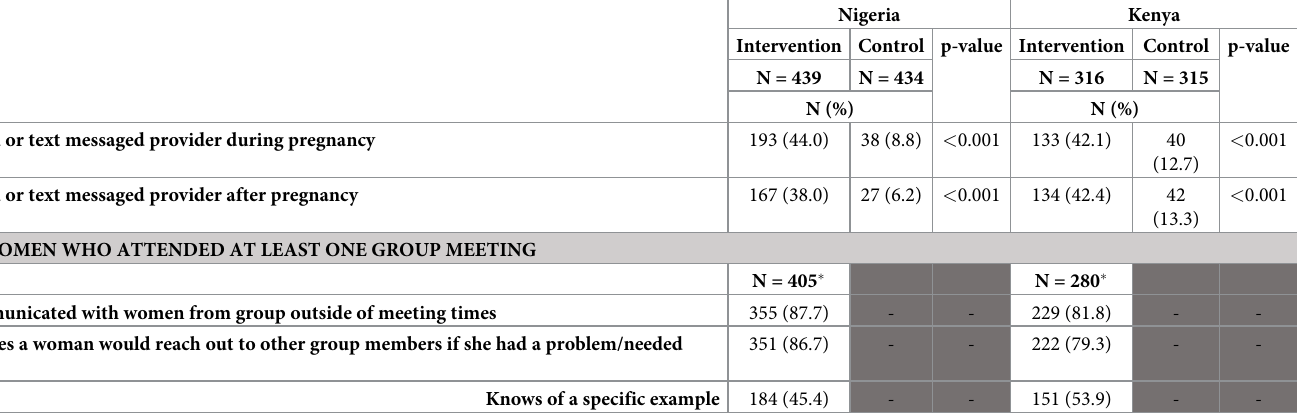
Table 8. Communication with providers and other group members outside of